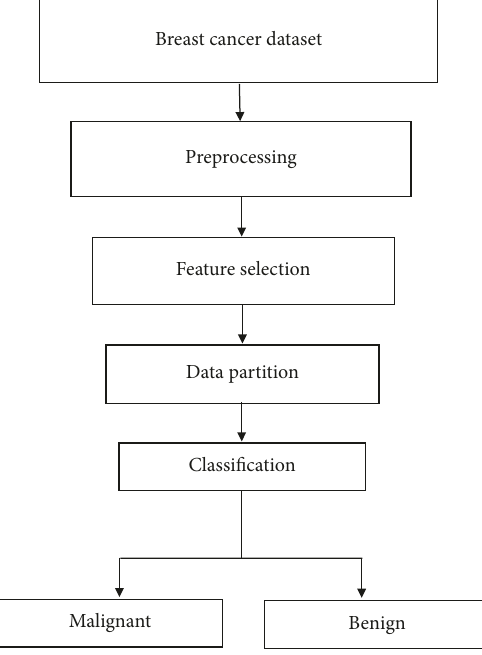
Figure 5: Framework of breast cancer detection by using IoT